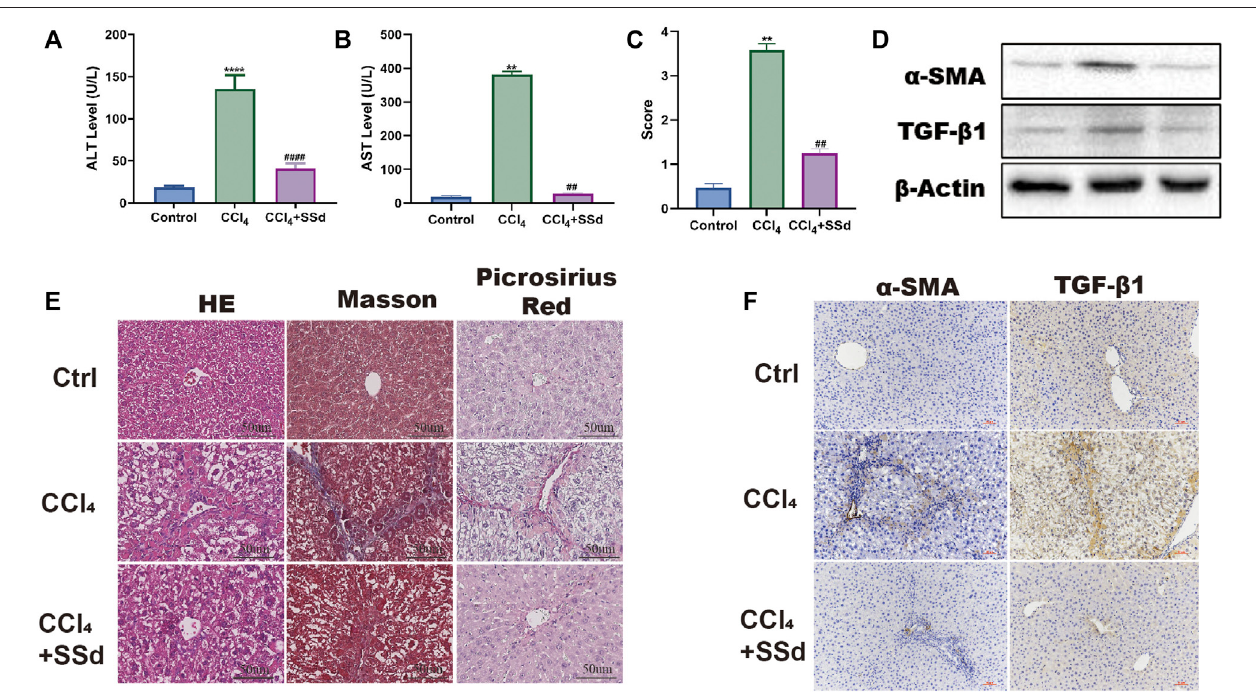
FIGURE 1 | SSd alleviated CCL 4 -induced liver injury and liver fi brosis. (A,B) the changes of serological ALT and AST concentration, n = 6. (C) Liver FibrosisScore, n =6. (D – F) liverhistologicaldetermination(H&E)andIHCof α -SMAandTNF- β (×200; scalebar:50 μ m).Dataareexpressed inmean±SEM;** p < 0.01,**** p < 0.0001, versus control group; ## p < 0.01, #### p < 0.0001, AND versus CCL 4 treated